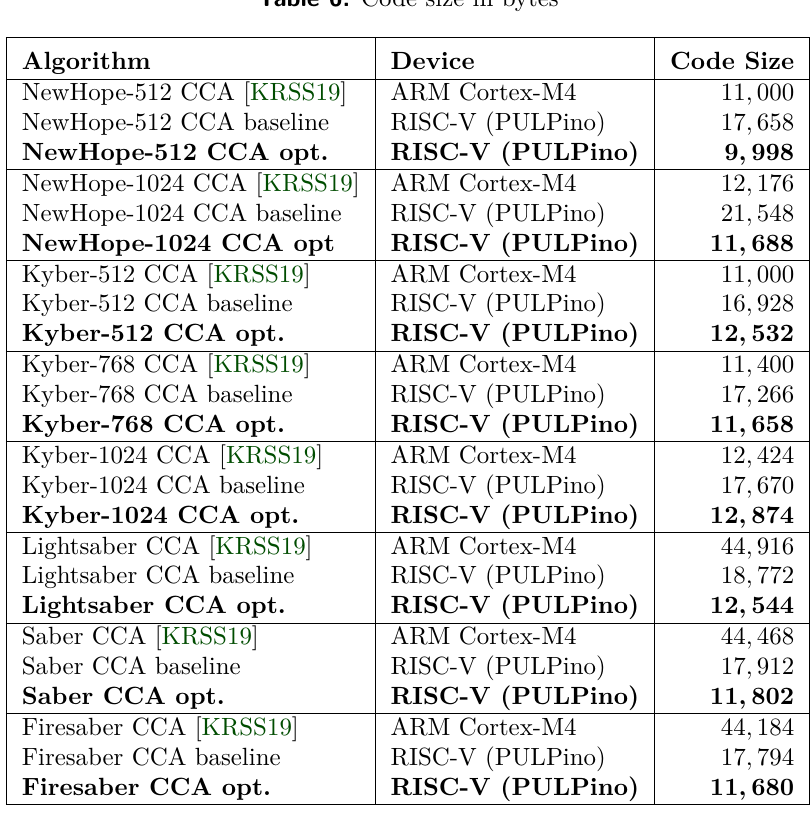
Table 6: Code size in